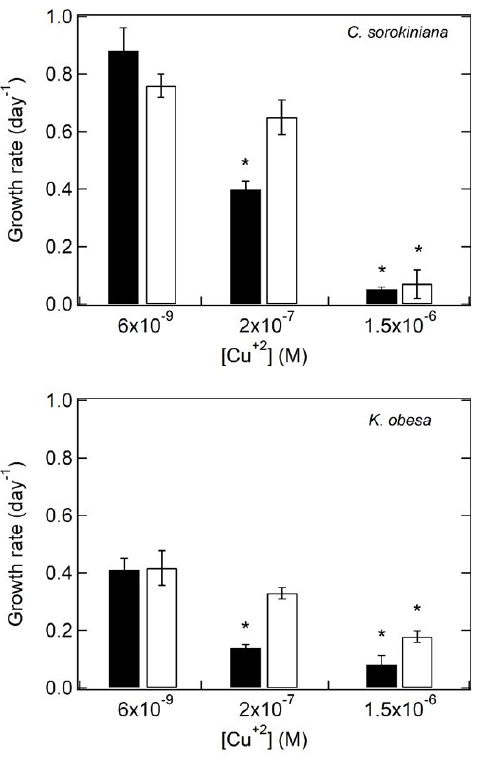
Figure 4. Growth rate (d -1 ) of Chlorella sorokiniana (up) and Kirchneriella obesa (down) in unialgal conditions (black bars) and co-cultivation (white bars) as a function of the copper concentrations tested with mean ± standard deviation. The symbol * represents statistically significant Figure 3. Chlorophyll a (μg mL -1 ) of Chlorella sorokiniana difference (p < 0.05) regarding the (up), Kirchneriella obesa (middle) and co-cultivation (down) as a function of experimental period in days with mean ± standard deviation. Copper concentration symbols: ○ (control, 6x10 -9 mol L -1 ), (intermediate, 2x10 -7 mol L -1 ) and □ (high, 1.5x10 -6 mol L -1 ). △